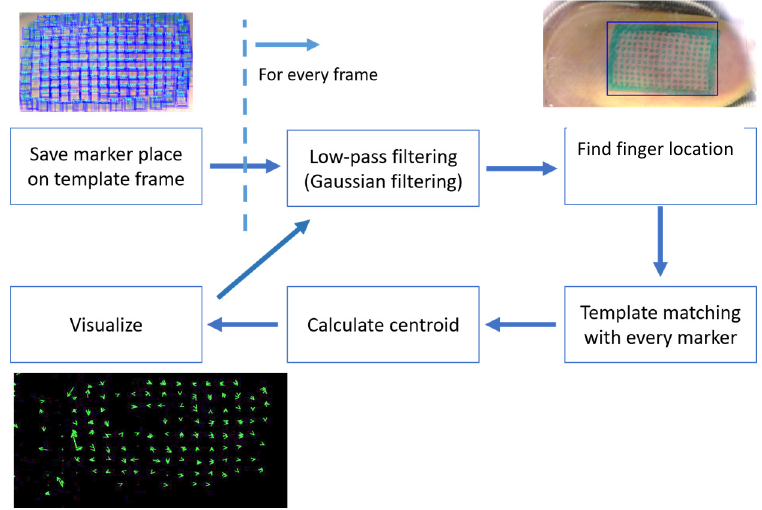
Figure 7. Flow of the image-processing algorithm.